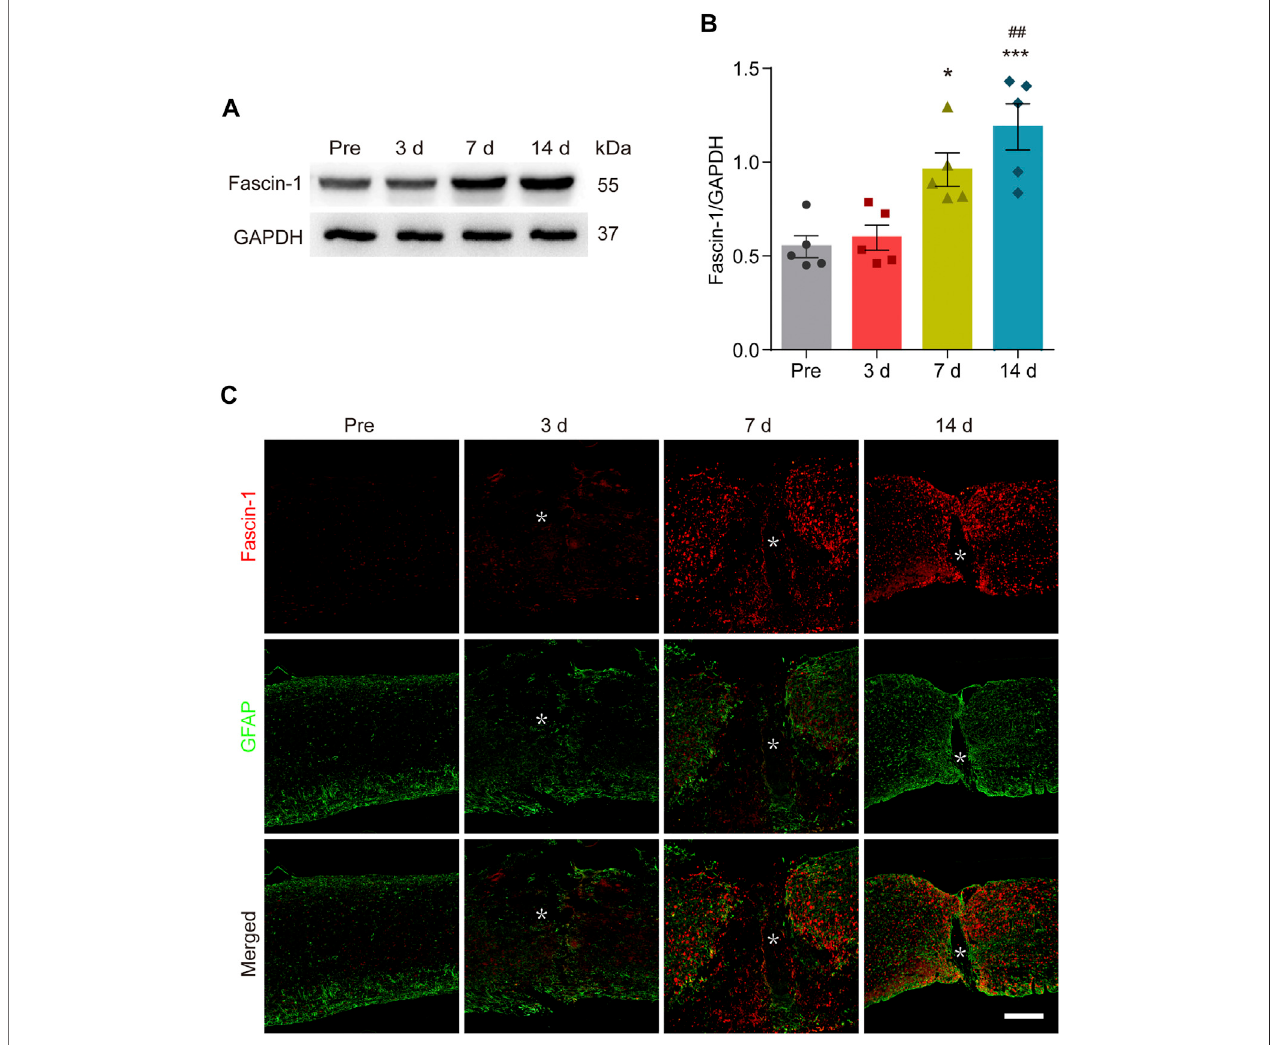
FIGURE 1 | Fascin-1 is prominently expressed and accumulates outside the lesion core after SCI. (A) Western blot analysis shows signi fi cant upregulation of Fascin-1at7and14 daysafterinjurycomparedtothecontrol(pre-operation,Pre). (B) QuantitativeanalysisofFascin-1expressionin (A) .Theblots( n (cid:2) 5pergroup)were quanti fi ed by a densitometric method using ImageJ software. GAPDH was used as the loading control. The results are expressed as the mean ± SEM. *** p < 0.001 (14 days vs Pre); * p < 0.05 (7 days vs Pre); ## p < 0.01 (14 vs 3 days). (C) Double immuno fl uorescence labeling of spinal cord sagittal sections showing the spatiotemporal distribution of Fascin-1 (Red) and GFAP (Green) at Pre and 3, 7, and 14 days after injury. The asterisks indicate the lesion epicenter. Scale bar: 500 μ m.